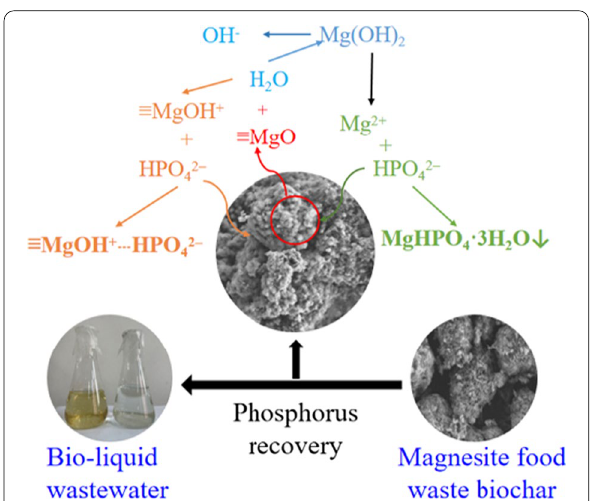
Fig. 6 Possible mechanisms of P recovery using